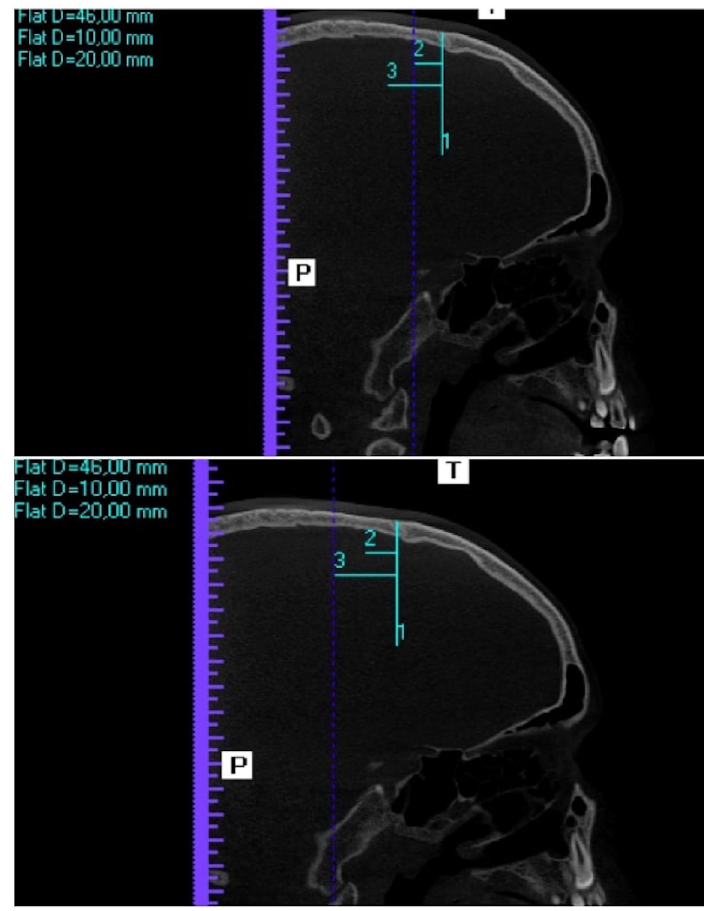
Figure 7- Blue line displaced 10 mm posterior to the coronal suture. Blue line displaced 20 mm posterior to the coronal